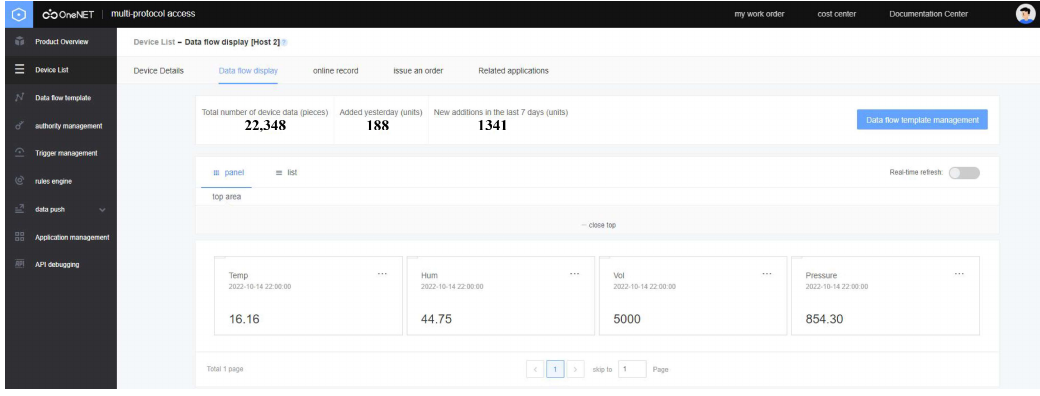
Figure 8. Cloud data platform.